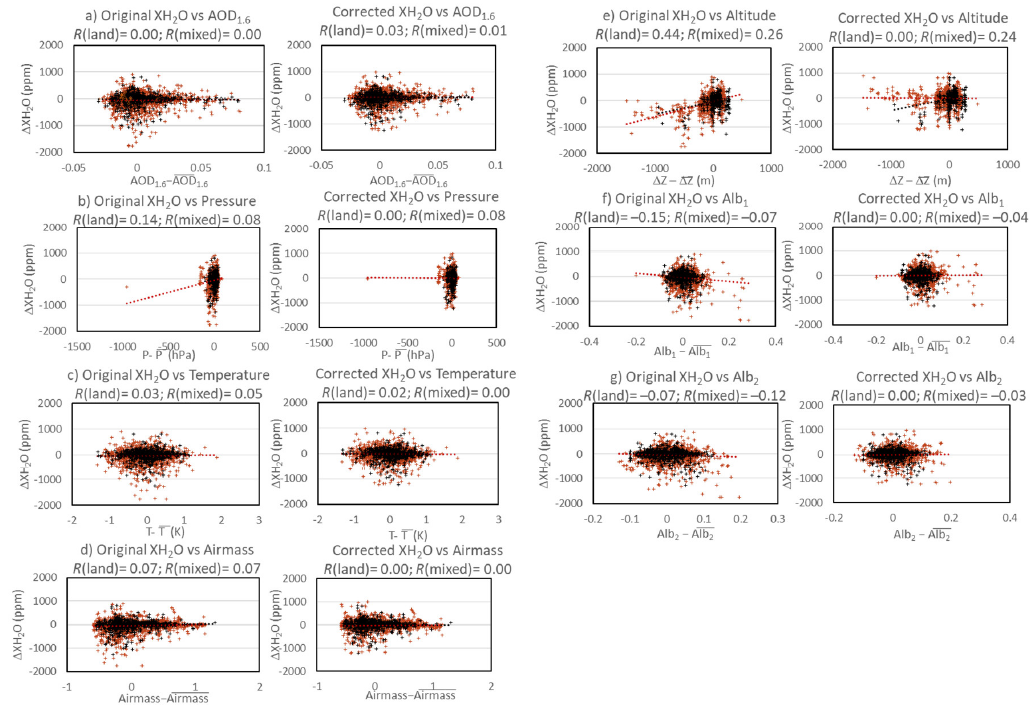
Figure 4. Scatter plots between ∆ XH 2 O calculated from original GOSAT SWIR XH 2 O data (left panels) or from GOSAT SWIR XH 2 O data corrected by bias-correction method (E) (right panels) and auxiliary parameters ( a ) AOD 1.6 , ( b ) surface pressure, ( c ) temperature shift, ( d ) air mass, ( e ) altitude, ( f ) Alb 1 , and ( g ) Alb 2 for case 0. Red symbols indicate GOSAT gain H land data, and black symbols indicate GOSAT gain H mixed for case 0. Red symbols indicate GOSAT gain H land data and black symbols indicate GOSAT gain H mixed data. The dotted lines are the fitted regression lines. ∆ XH 2 O = GOSAT XH 2 O – TCCON XH 2 O.